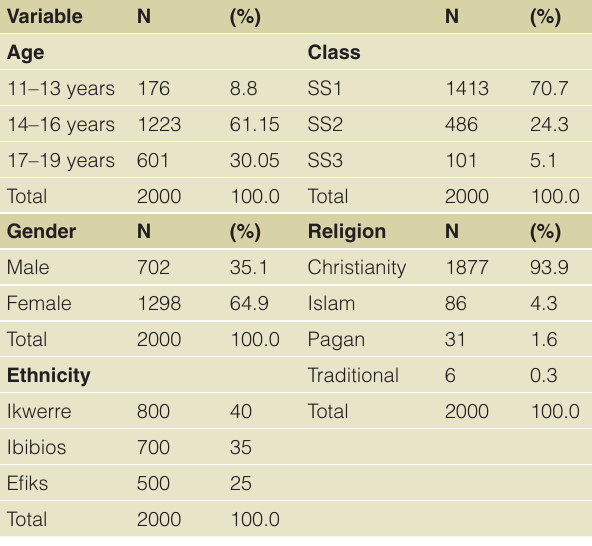
Table 1. Demographic characteristics of study participants by frequency and